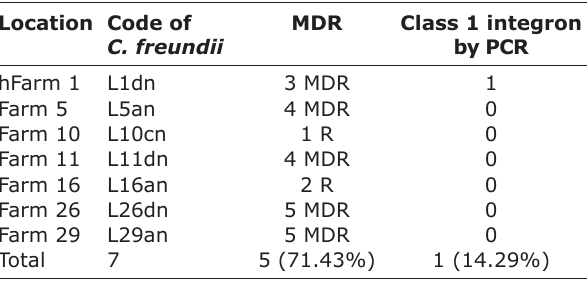
Table-3: Prevalence of MDR and Class 1 integron in C. freundii isolated from laying chickens. Location Code of C. freundii